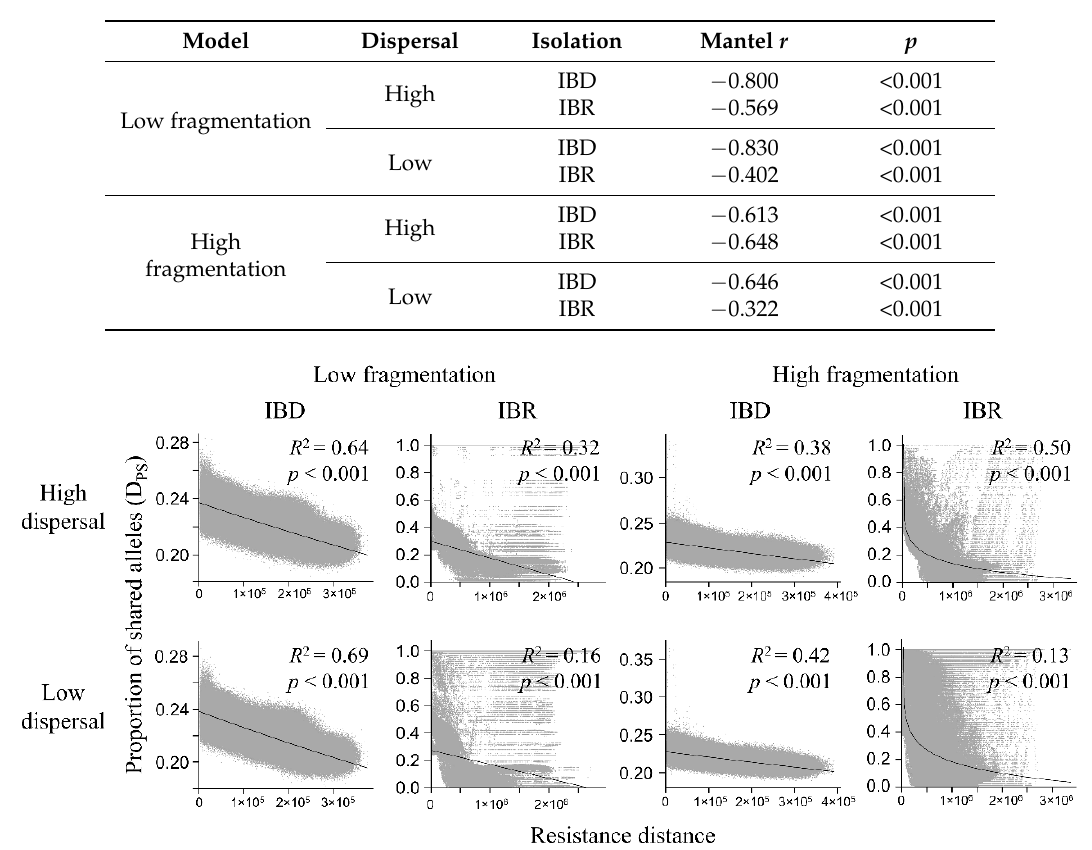
Table 1. Mantel tests relating the proportion of shared alleles (D ps ) and resistance distance matrices in the low-fragmentation model and the high-fragmentation model under high-dispersal (300 km) and low-dispersal (200 km) scenarios. Significance of matrix correlations was tested by 1000 permutations.